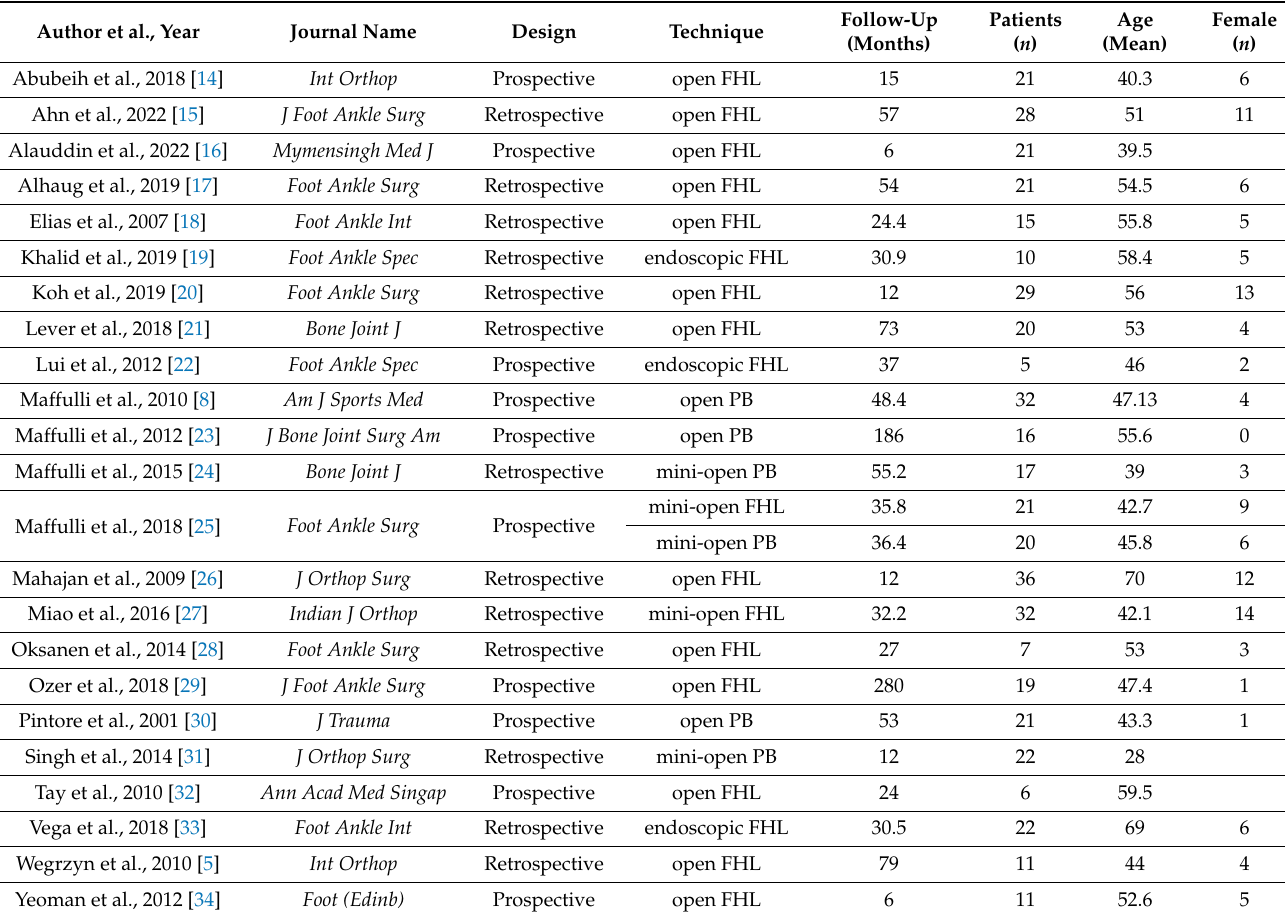
Table 3. Generalities and patient baseline databases.